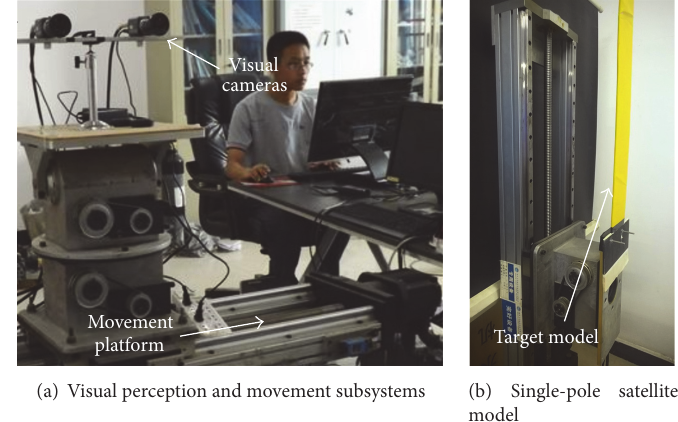
Figure 11: Visual servoing control